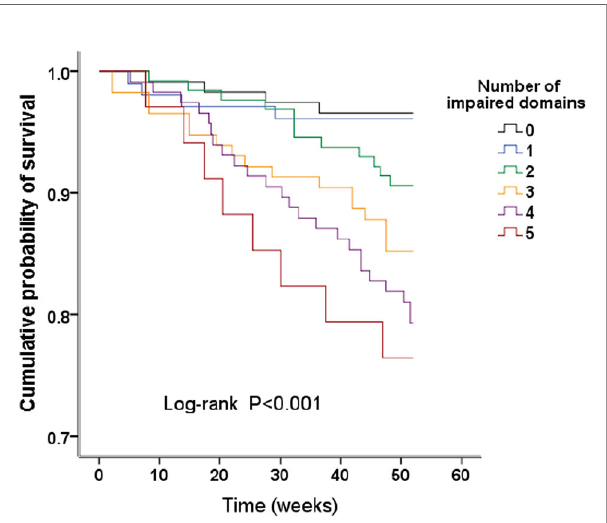
FIGURE 2 | Kaplan – Meier survival curves. Survival analysis strati fi ed by the number of impaired